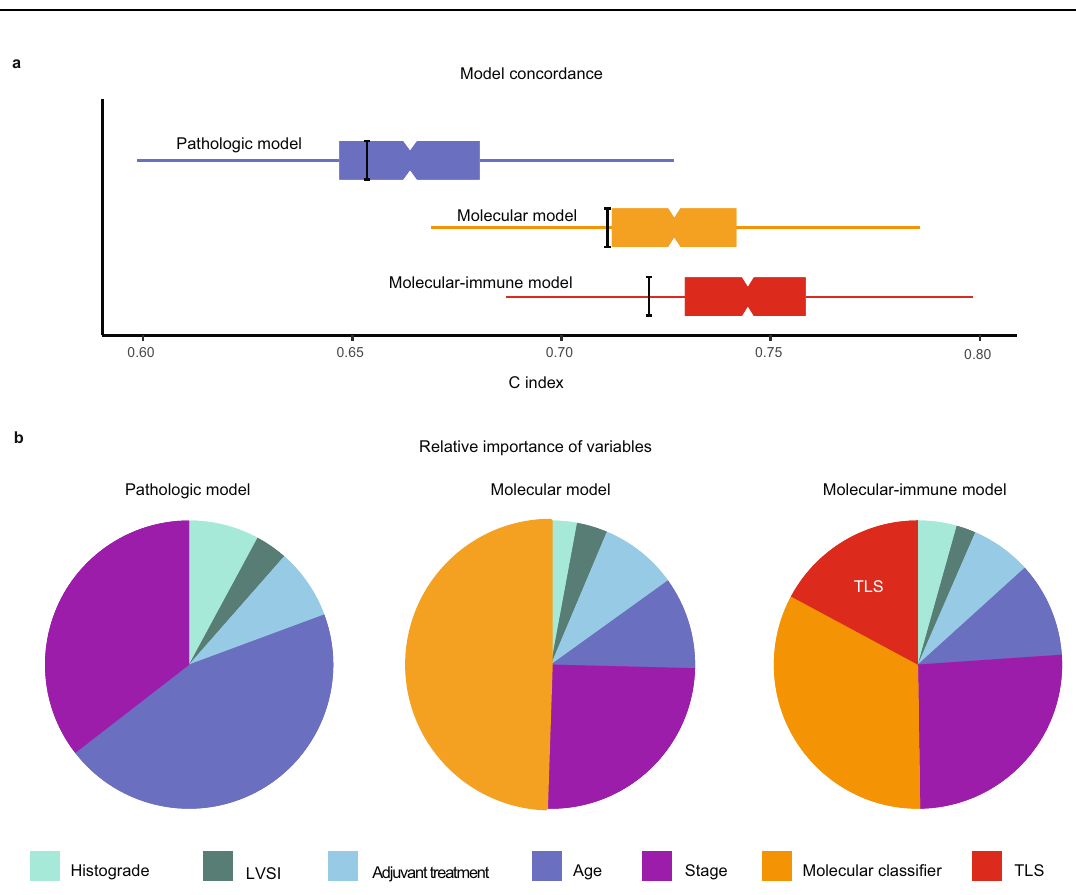
Fig. 5 Characteristics of prognostic models in high-risk endometrial cancer. a Boxplots showing concordance (C index) of the pathologic model, molecular model and the molecular-immune model. Box and whisker (Tukey) plots use results of 1000 bootstrap resamples from study population; lower and upper limits of box indicate 25th and 75th percentiles; and whiskers extend to 1.5x interquartile range below and above these values, respectively. The thick black bars indicate the C index from original population. b Pie charts showing relative importance of variables within these three multivariable models based on the proportion of the χ 2 statistic. LVSI Lymphovascular space invasion; TLS Tertiary lymphoid